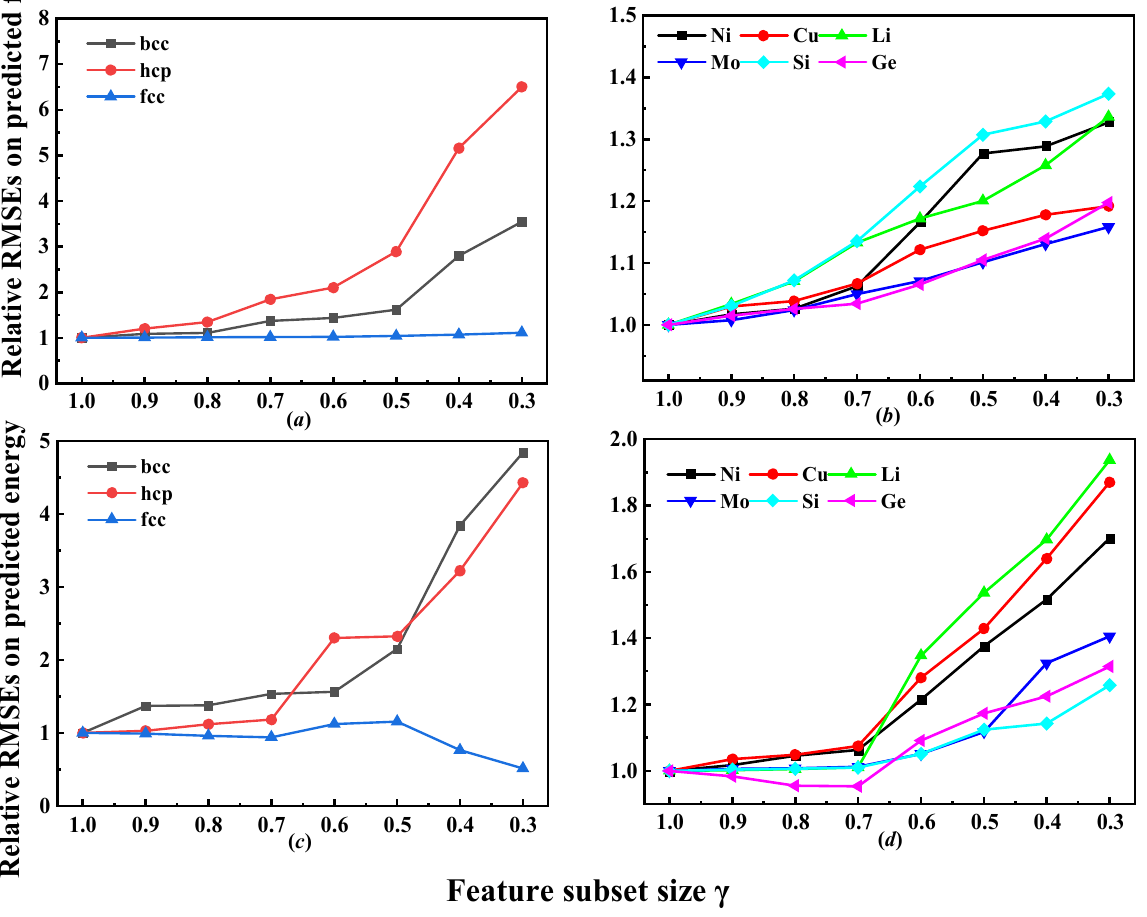
Figure 8. Trend analysis of the influence of feature subset size on prediction performance. ( a ) Force RMSE on Fe (bcc, hcp, and fcc); ( b ) force RMSE on Ni, Cu, Li, Mo, Si, and and Ge. ( c ) Energy RMSE on Fe (bcc, hcp, and fcc); ( d ) energy RMSE on Ni, Cu, Li, Mo, Si, and Ge. In summary, when γ is set to be 0.7, the energy and force prediction performance can be guaranteed, which helps to reduce the computational